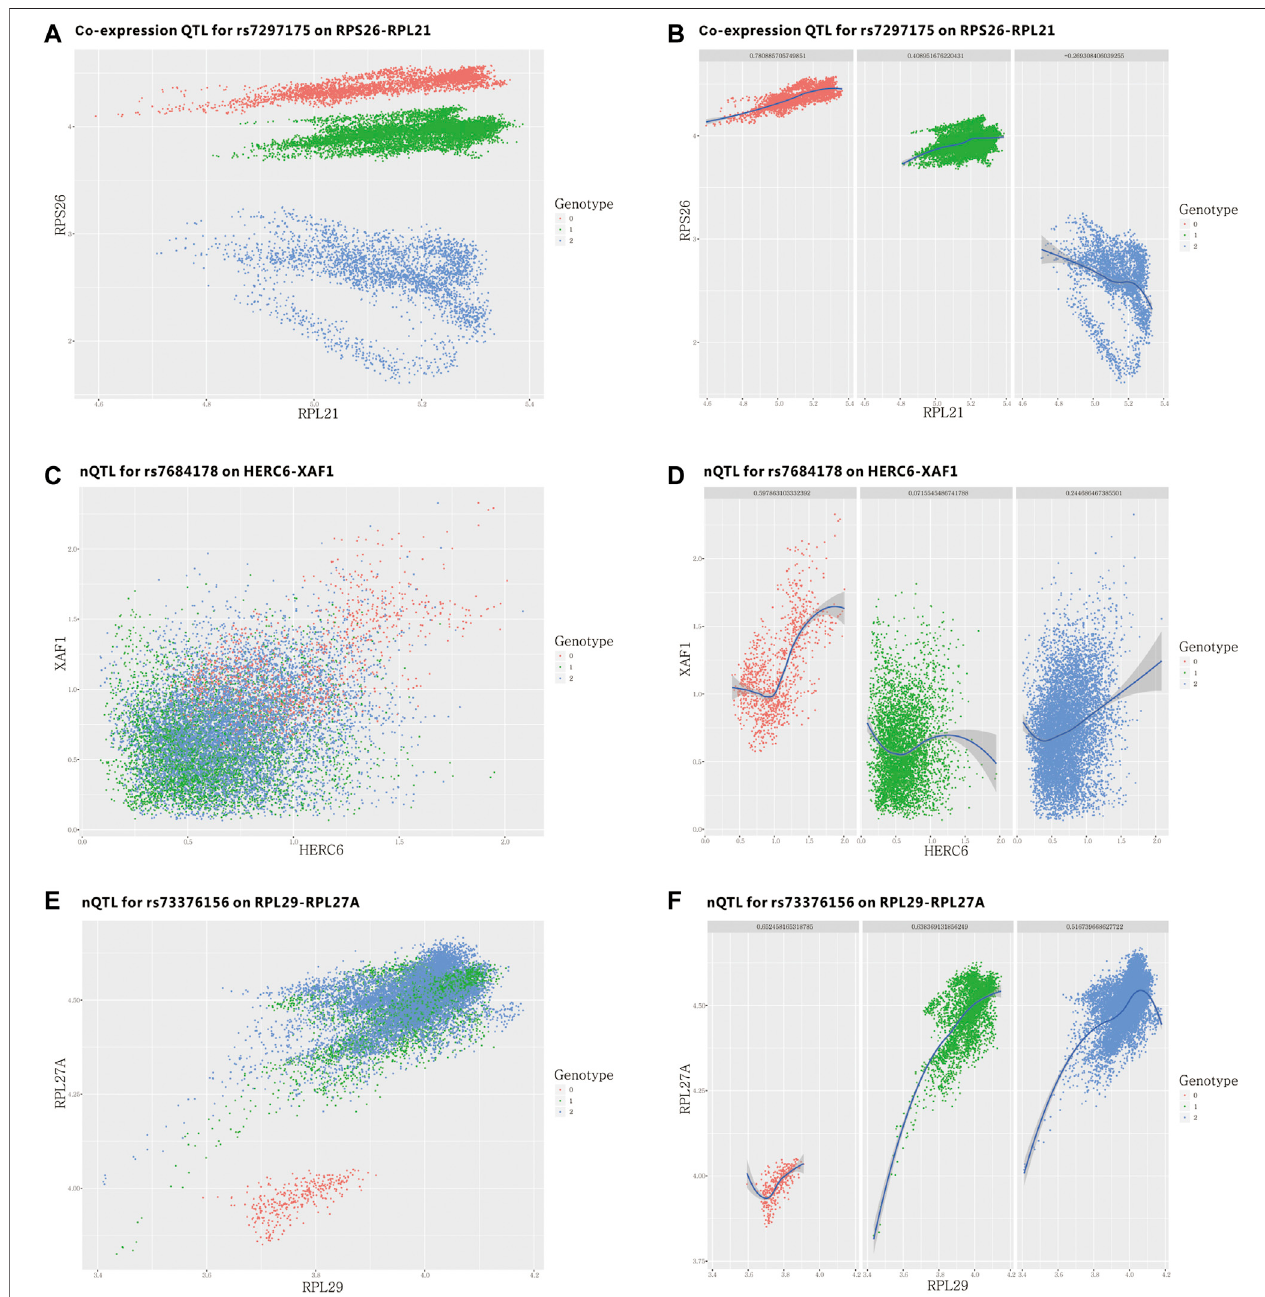
FIGURE7| SNP – edgeassociations(edgetraits)detected unsupervisedbythenQTLframeworkandtheirassessmentsonsingle-celldatafromthehumanPBMC dataset. (A , B) Single-cell plot of previously reported SNP and gene-pair association. (C – F) Single-cell plot of our newly identi fi ed SNP and gene-pair associations.